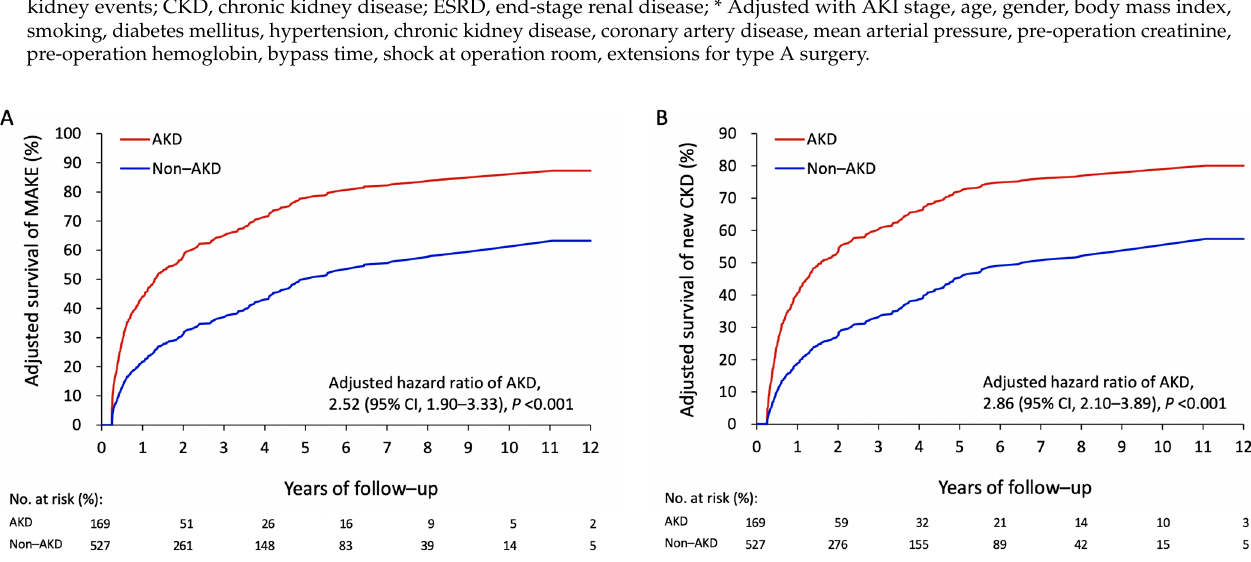
Figure 3. Directly adjusted one minus survival rates of MAKEs ( A ) and newly diagnosed CKD ( B ) after type A acute aortic dissection surgery in patients with or without AKD. MAKEs, major adverse kidney events; CKD, chronic kidney disease.